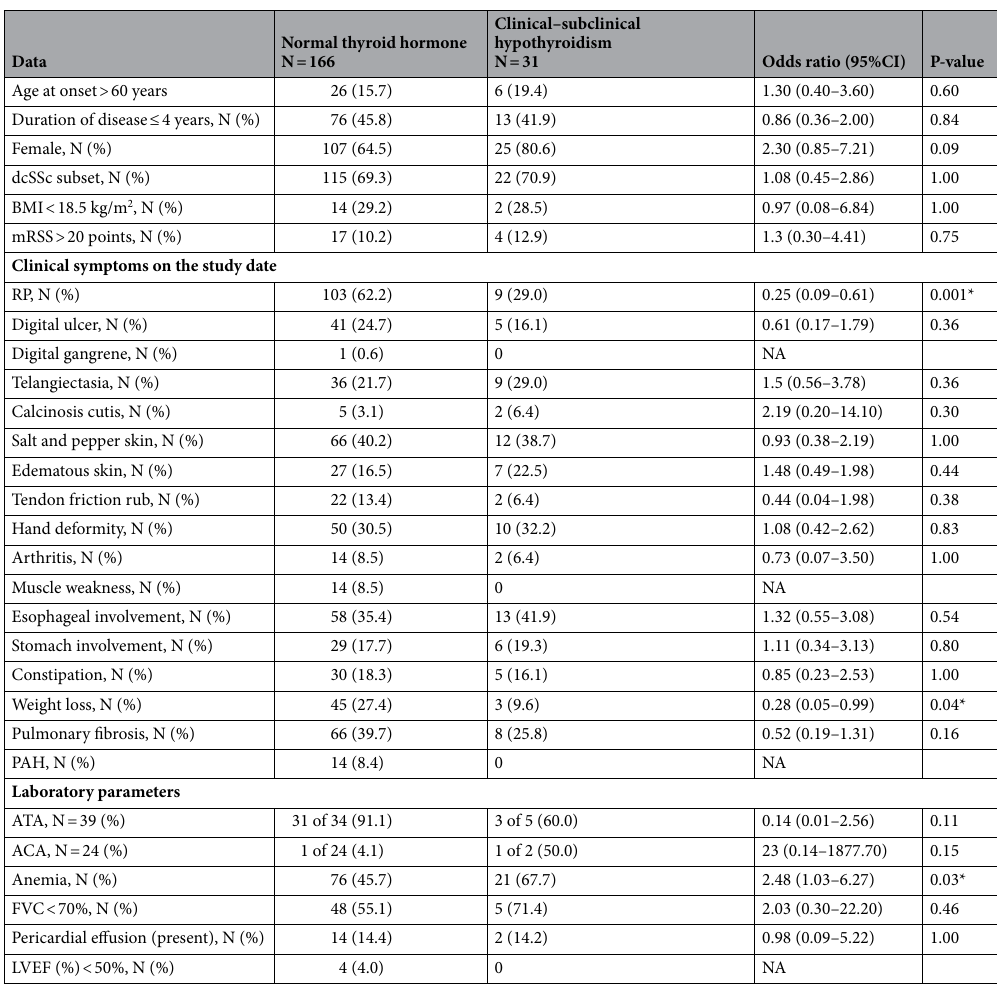
Table 2. Clinical parameters associated with clinical-subclinical hypothyroidism. CI: confidence interval; dcSSc: diffuse cutaneous systemic sclerosis; BMI: body mass index; RP: Raynaud’s phenomenon; PAH: pulmonary arterial hypertension; ATA: anti-topoisomerase I antibody; ACA: anti-centromere antibody; FVC forced vital capacity; LVEF left ventricular ejection fraction; NA: data not available due to a